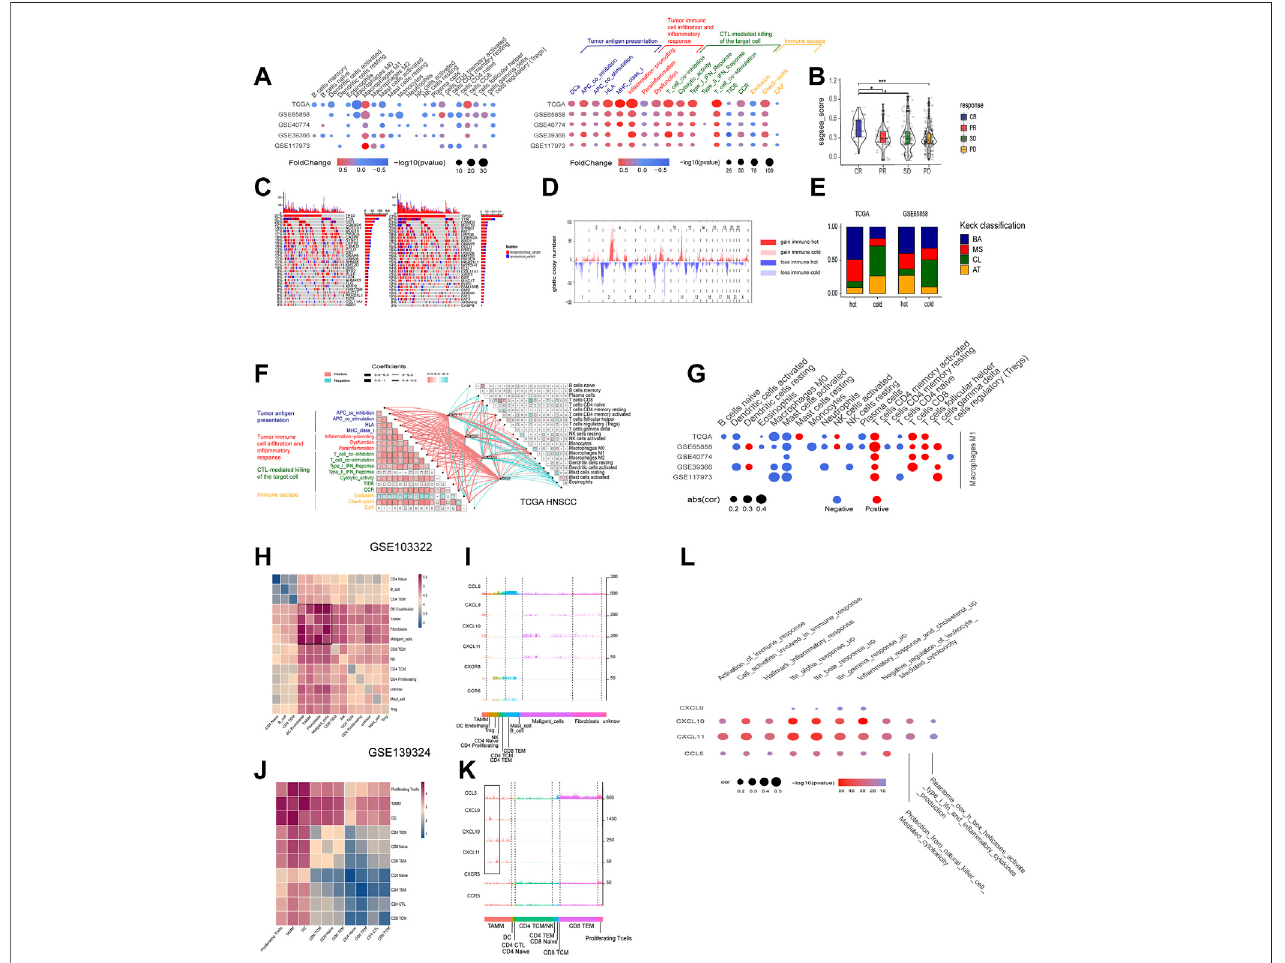
FIGURE 6 | The roles of the four chemokines (CXCL9,10,11, and CCL5) in HNSCC TME and their association with tumor genomic changes. (A) Dotplot summarized the scores of 22 immune cells estimated by GIBESORTRT and GSVA scoring on the fold change and p .adjust of 29 immune signature between the immune hot and cold group classi fi ed by the median GSVA of the four chemokines (only p < 0.05 was given). (B) Vilionplot summarized the GSVA scores of CXCL9, CXCL10, CXCL11, and CCL5 of four outcomes (CR, PR, PD, SD) in the cohort receiving anti-PD-1/PD-L1 immunotherapy. (C) The OncoPrint was constructed between high and low scores of the top 30 genes with the highest mutation frequency. (D) CNV plot showed the frequency of copy-number gains (red) and deletions (blue) among immune hot and cold groups of the TCGA-HNSC cohort. (E) The stacking histogram showed the distribution of Keck classi fi cation in the immune hot and cold groups of TCGA HNSCC and gse65858 cohorts. (F) Correlation between the four chemokines and GIBESORTRT score of 22 immune cells in HNSCC- TCGA and 29 immune signature GSVA score. The cell charts in the upper-right triangular exhibited the correlation among the 22 immune cell scores, and the cell charts in the -lower triangular showed the correlation among the 17 immune signature scores (Red stood for positive and green for negative, the darkness and lightness of the colors for the high and low of the coef fi cients, and the size of the cell for p value). The lines between two cell charts represent the correlation of the mRNAofthe fourchemokineswiththebilateralimmunescores(Redstoodforpositiveandgreenfornegative,andthethicknessofthelinesforthe highandlowofthe coef fi cients). (G) Dotplot summarized the correlation coef fi cients between the scores of 21 immune cells estimated by GIBESORTRT and the scores of Macrophage M1estimated by GIBESORTRT(only p < 0.05wasgiven). (H,J) Heatmapofaverageexpression levelofligand – receptor interactionsin allclustersin GSE103322and GSE139324. (I,K) Histogram of expression levels of CCL5, CXCL9, CXCL10, CXCL11, CXCR3, and CCR5 in each cell in GSE103322 and GSE139324 cohorts. (L) Dotplot summarized the correlation coef fi cients between the expression level of CXCL9, CXCL10, CXCL11, and CCL5, and the GSVA of 10 immune signatures in each cells classi fi ed as TAMM.